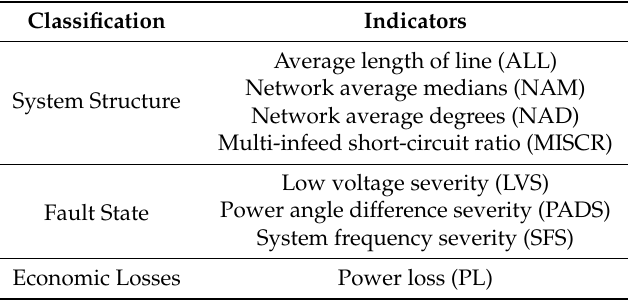
Table 1. Risk assessment indicator